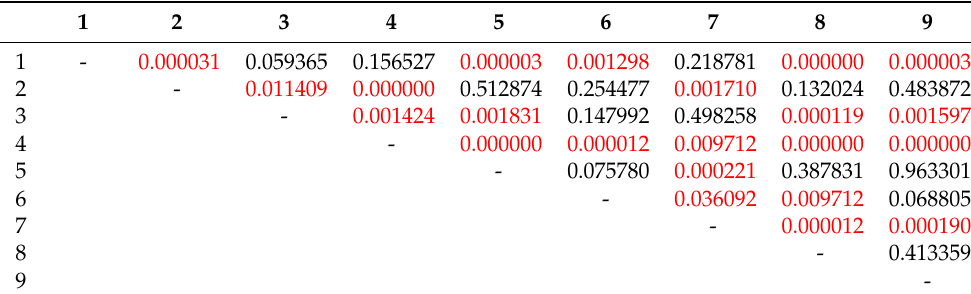
Table A1. Probabilities for post hoc testing for three-point bending flexural strength (FS) of tested matrices. Tested group: 1-UDMA/bis-GMA/TEGDMA 70/10/20, control; 2-UDMA/bis- GMA/TEGDMA 70/10/20, thermocycling +NaOH, 3-UDMA/bis-GMA/TEGDMA 70/10/20, 5 d water + NaOH, 4-UDMA/bis-GMA/TEGDMA 40/40/20, control; 5-UDMA/bis-GMA/TEGDMA 40/40/20, thermocycling +NaOH; 6-UDMA/bis-GMA/TEGDMA 40/40/20, 5d water + NaOH; 7-UDMA/bis-EMA/TEGDMA 40/40/20, control; 8-UDMA/bis-EMA/TEGDMA 40/40/20, thermo- cycling +NaOH, 9-UDMA/bis-EMA/TEGDMA 40/40/20, 5 d water + NaOH.